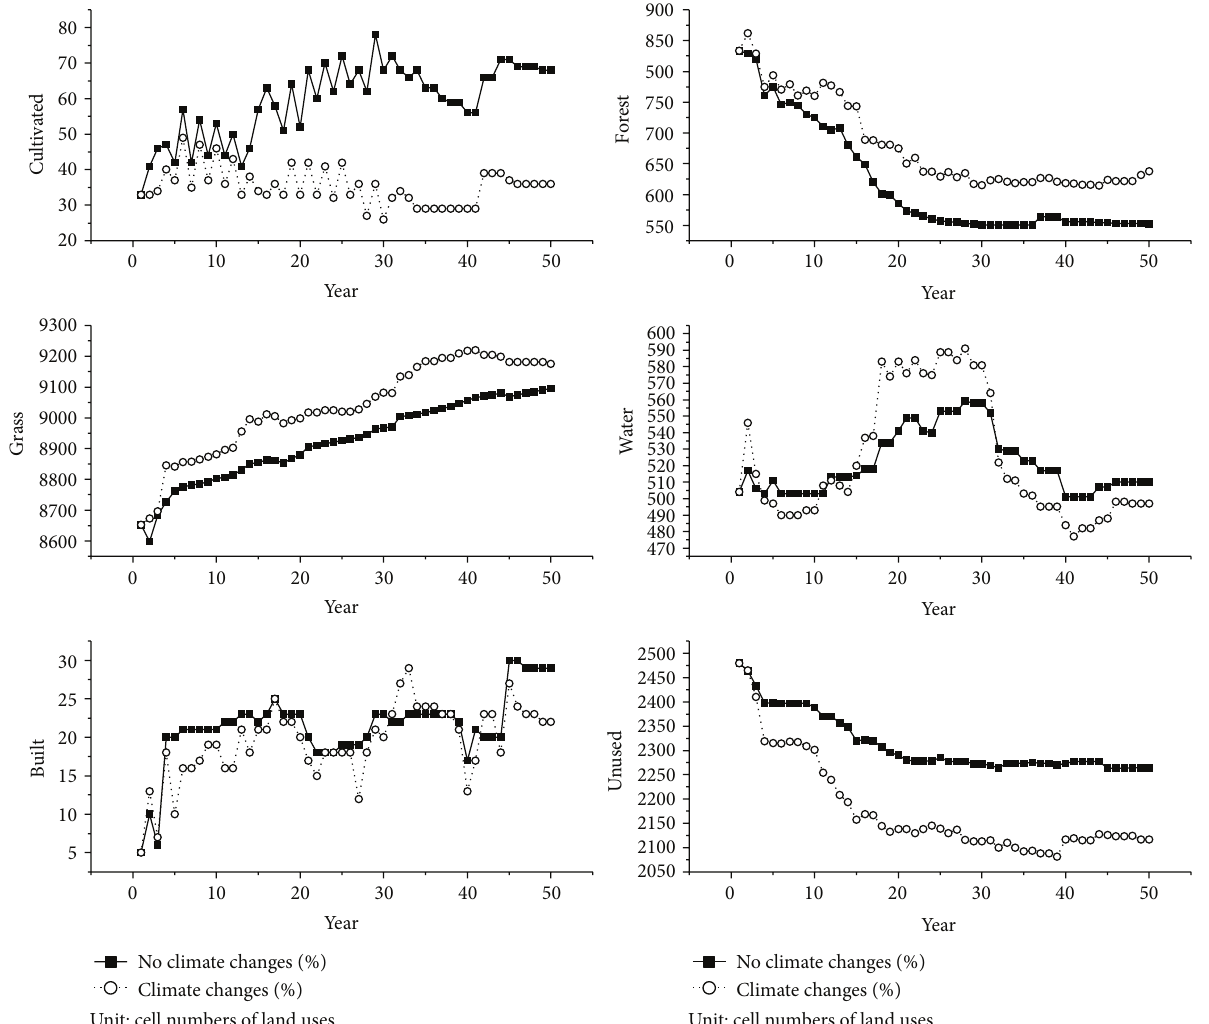
Figure 2: Simulation results of the land uses under the scenario with and without climate changes. The picture shows the cell numbers of each land use in every simulation step.